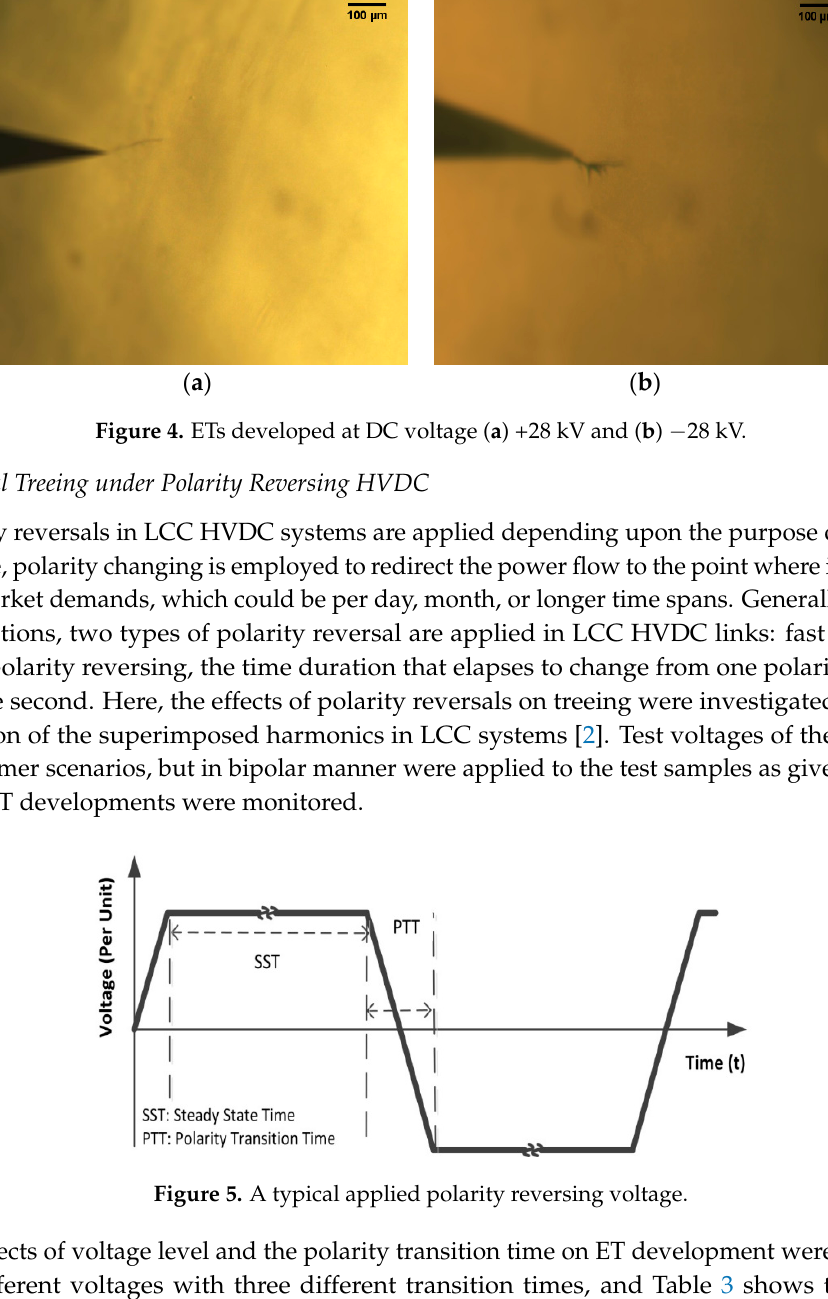
Figure 5. A typical applied polarity reversing voltage.